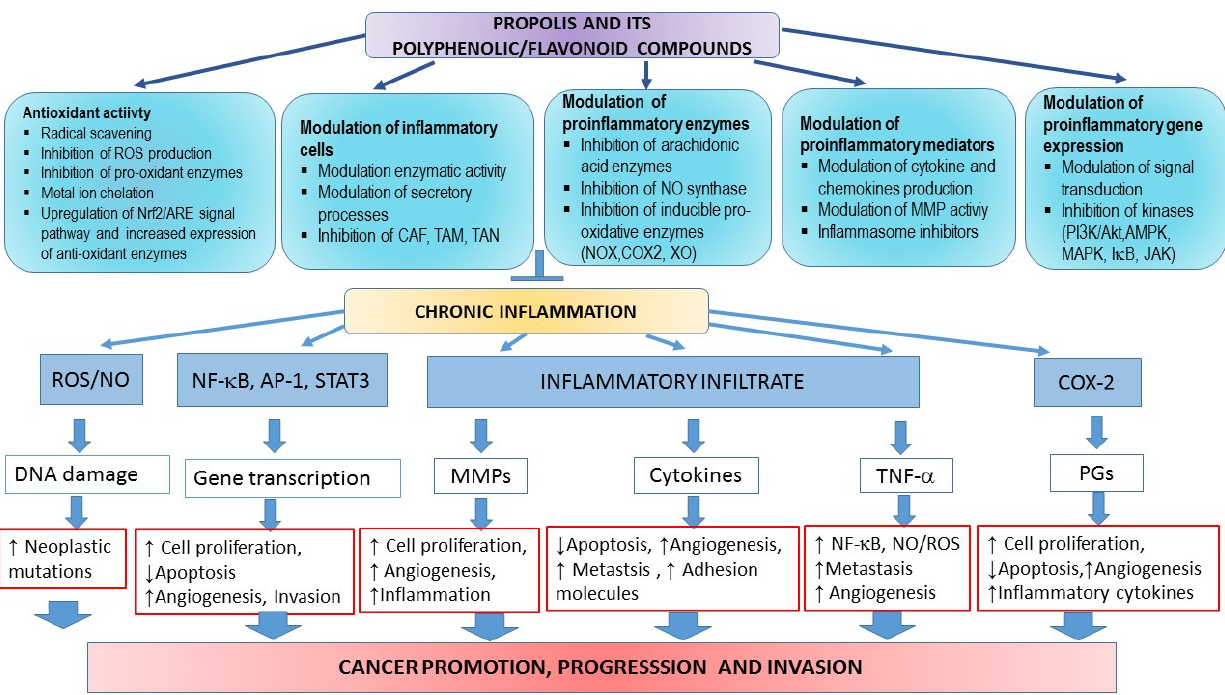
Figure 2. Potential therapeutic strategies to treat cancer promotion and progression by propolis and its polyphenolic/flavonoid compounds. The role and possible mechanisms of action of propolis and its flavonoids in regulation of inflammatory pathways by (i) antioxidative and radical scavenging activities, (ii) regulation of cellular activities of inflammatory cells, (iii) modulation of the enzymes involved in arachidonic acid metabolism (phospholipase A2, cyclooxygenase, and lipoxygenase) and nitric oxide synthase, (iv) modulation of the release of other pro-inflammatory molecules, and (v) transcriptional modulation of proinflammatory genes are shown. Note: ROS, Reactive oxygen species; NO, Nitric oxide; NF- κ B, Nuclear factor kappa-light-chain-enhancer of activated B cells; COX-2, Cyclooxygenase-2; MMPs, Matrix metalloproteinases; TNF- α , Tumor necrosis factor-alpha; PGs, Prostaglandins; CAF, Cancer-associated fibroblast; TAM, Tumor-associated macrophages; NOX, Nicotinamide adenine dinucleotide phosphate (NADPH) oxidases; XO, Xanthine oxidase; PI3/Akt, Phosphatidylinositol 3-kinase (PI3K)/protein kinase B (AKT); AMPK, AMP-activated protein kinase; I κ B, Nuclear factor of kappa light polypeptide gene enhancer in B-cells inhibitor; JAK, Janus kinases; AP-1, Activator protein 1; STAT3, Signal transducer and activator of transcription 3